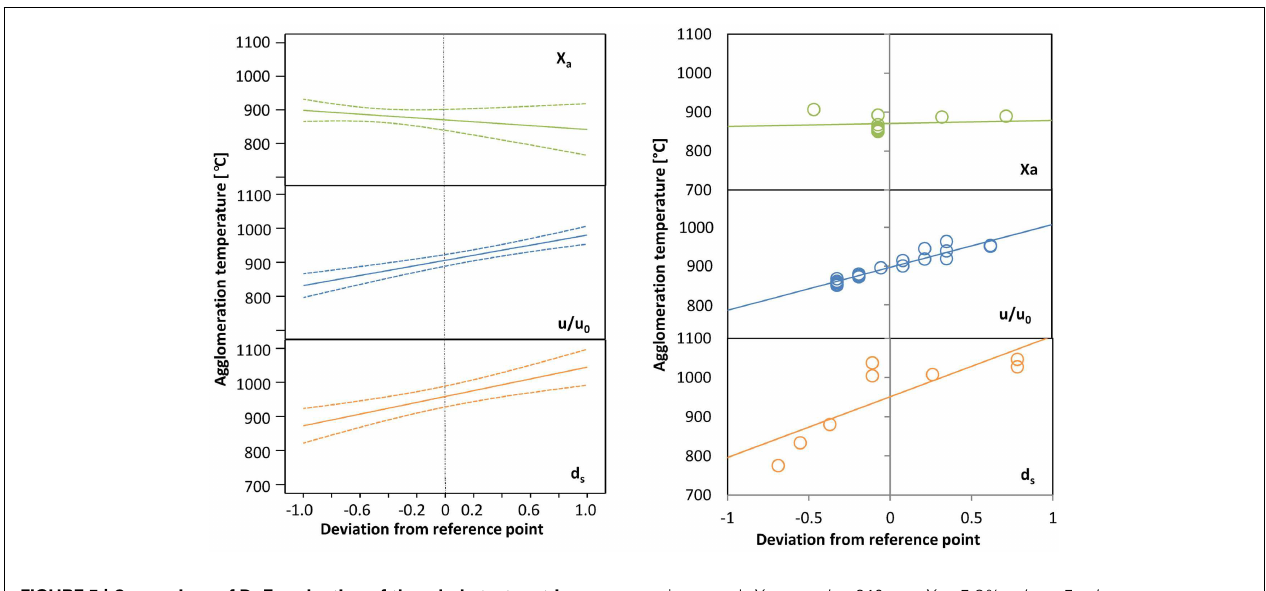
FIGURE 5 | Comparison of DoE evaluation of the whole test matrix (left) and independent test runs (right) . Solid line represents a linear trendline, dotted lines show the DoE confidence intervals.